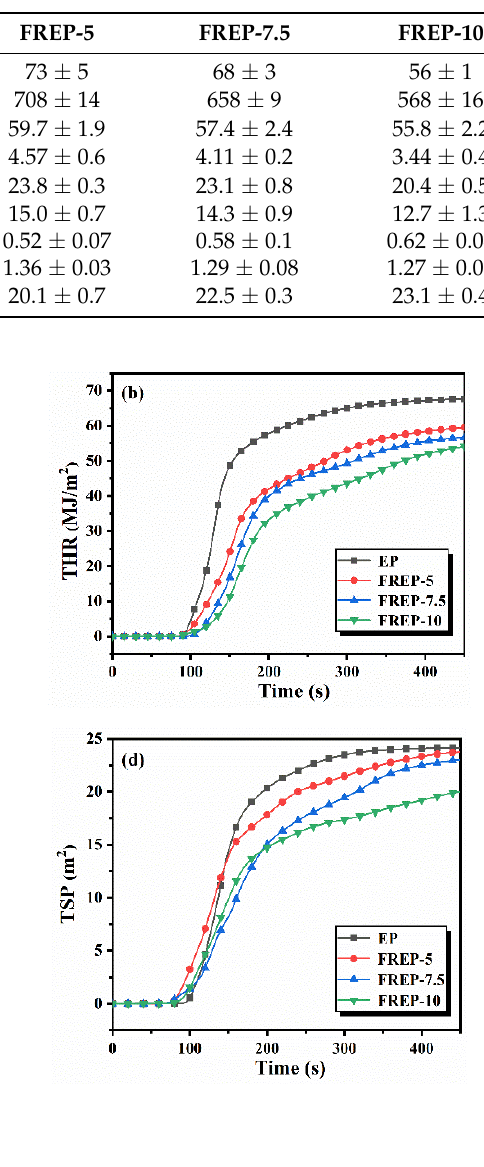
Table 5. Combustion data obtained from CCT.